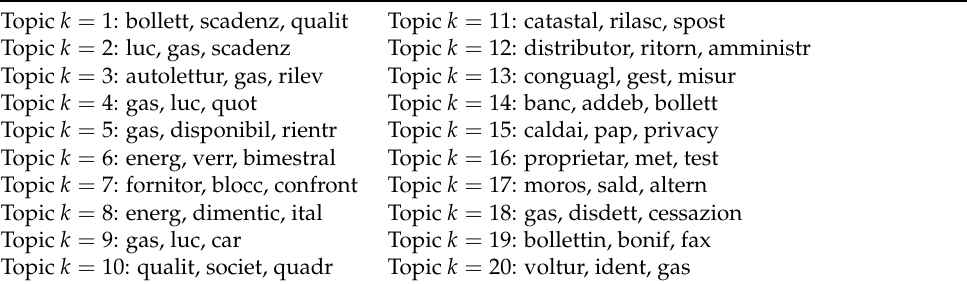
Table 1. Top 3 words for the 20